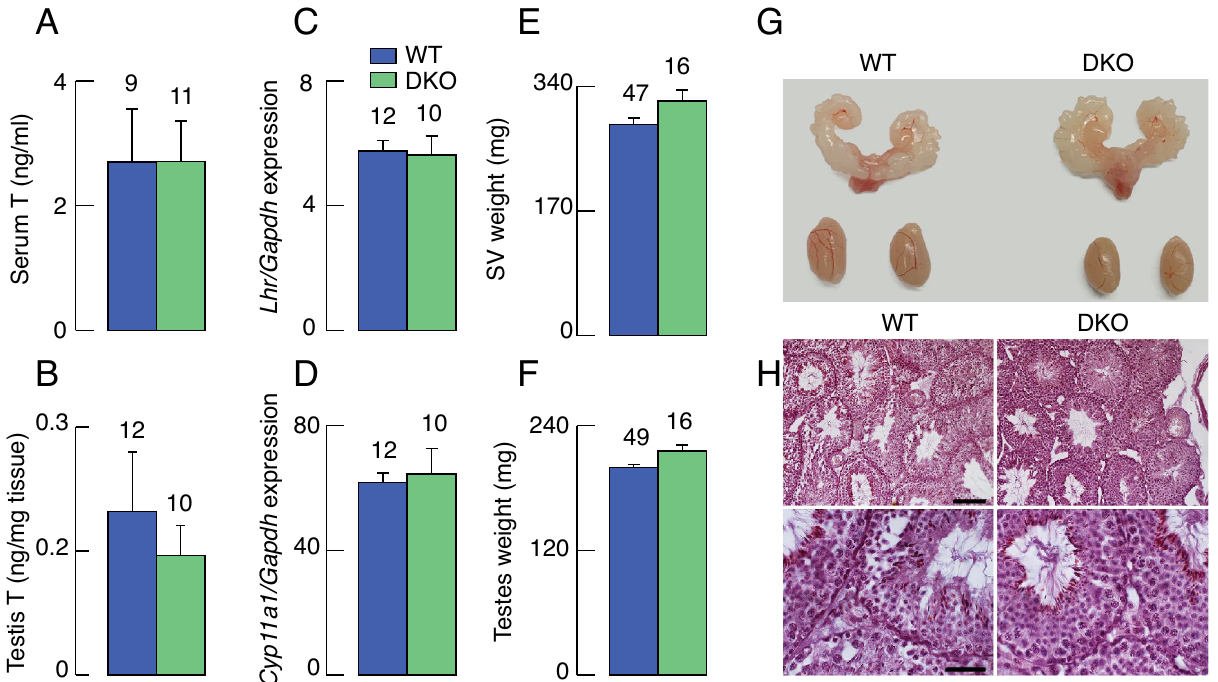
Figure 2. Lack of effects of DKO on male reproductive system. ( A , B ) Testosterone levels in WT and DKO animals: serum (A) and testes (B). ( C , D ) Expression of testicular genes in WT and DKO animals: Lhr (C) and Cyp11a1 (D); the expression of other testicular genes was also comparable in WT and DKO animals, including Fshr, Cyp17a1 , Hsd17b1 , and Hsd3b1. (E–H) Reproductive organs in WT and DKO males: mean ± SEM weight values for seminal vesicles (E), testes (F), representative examples of these organs (G), and histological evidence for normal spermatogenesis and spermiogenesis in both groups using hematoxylin staining; scale bars: 100 µm for upper and 40 µm for lower panel (H). Data shown are mean ± SEM values; with numbers of replicates per group shown above bars; asterisks, P < 0.01 between pairs. The age of the animals (days) was WT = 103.24 ± 1.66 (N = 49); DKO = 108.9 ± 3.08 (N = 16). The body weight (g) of the animals was WT = 27.85 ± 0.31; DKO = 27.56 ± animals (Fig. 2E–G) and histological analysis confirmed spermatogenesis and spermiogenesis, with spermatozoa present in tubule lumen of both WT and DKO animals (Fig. 2H). DKO inhibits Lhb expression and LH accumulation in pituitary glands. Within pituitary cell types, gonadotrophs specifically express several genes, including Lhb, Fshb, Gnrhr, nuclear receptor subfamily 5 group A member 1 ( Nr5a1 ), and secreted phosphoprotein 1 ( Spp1 ) and together with thyrotrophs also express glyco- protein hormones, alpha polypeptide gene ( Cga ) 8,25 . Here we analyzed the expression of these genes in pituitary glands from WT and DKO females and males (Fig. 3). The expression of Lhb was significantly reduced in pitui- taries of DKO females compared to WT females in estrus, metestrus and diestrus, with percentage reduction of 40%, 38% and 28%, respectively. Lhb expression was also significantly reduced in DKO males by 36% (Fig. 3A). Similarly, Gnrhr expression was significantly reduced in DKO females compared to estrous, metestrus, and dies- trus controls by 31%, 42%, and 29%, and in DKO males for 20% (Fig. 3B). Fshb expression was also significantly reduced in DKO females and males, compared with random cycling females (by 37%) and control males (by 35%) (Fig. 3C). In contrast, no significant changes in expression of Cga was observed in DKO animals, when compared to WT animals (Fig. 3D). The expression of Nr5a1 (Fig. 3E) and Spp1 (Fig. 3F) was also not affected in DKO males and females. These results indicate that there is no sex-specific difference in gonadotroph-specific gene expression in DKO animals compared to age-matched controls. Transcription of Lhb, Fshb , and Gnrhr is stimulated by GnRH 26 and Spp1 expression is unaffected by GnRH 27 , suggesting that endogenous GnRH secre- tion is reduced in DKO animals. In further experiments, we examined whether the reduction in Lhb expression affects the synthesis and release of LH. In the first experiment, we used western blotting to analyze LHB content in male (Fig. 4A, top) and female (Fig. 4A, bottom) pituitaries from WT in the diestrus stage of estrous cycle and DKO mice. Contrary to the sex- specific effects of DKO on reproduction, we observed lower density of LHB bands in both DKOs, females and males, when compared to the WT animals of the same age. In females, we further compared the density of LHB bands from DKO females with bands from WT animals in proestrus, estrus, and diestrus stage of estrous cycle. This analysis confirmed that density of LHB bands was lower in DKO females than in any stage of estrous cycle in WT females (proestrus = 1 ± 0.12, DKO = 0.36 ± 0.06; estrus = 1 ± 0.08, DKO = 0.52 ± 0.09; diestrus = 1 ± 0.08, DKO = 0.51 ± 0.11).